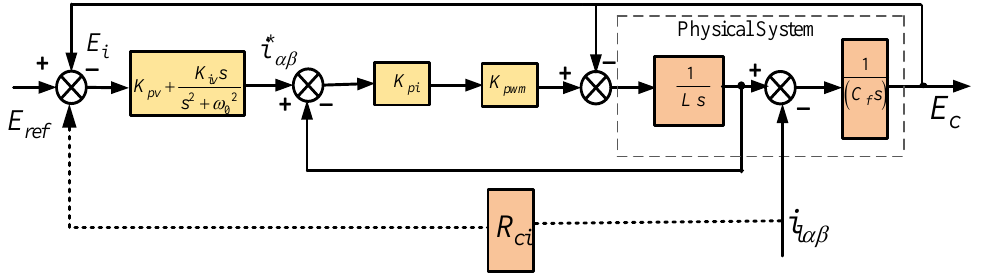
Figure 6. Closed loop control block diagram of 3-level inverter.